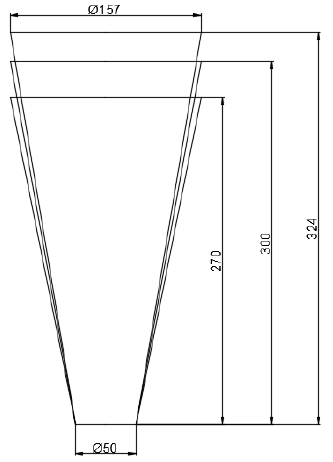
Figure 13. Dimension of the cones.